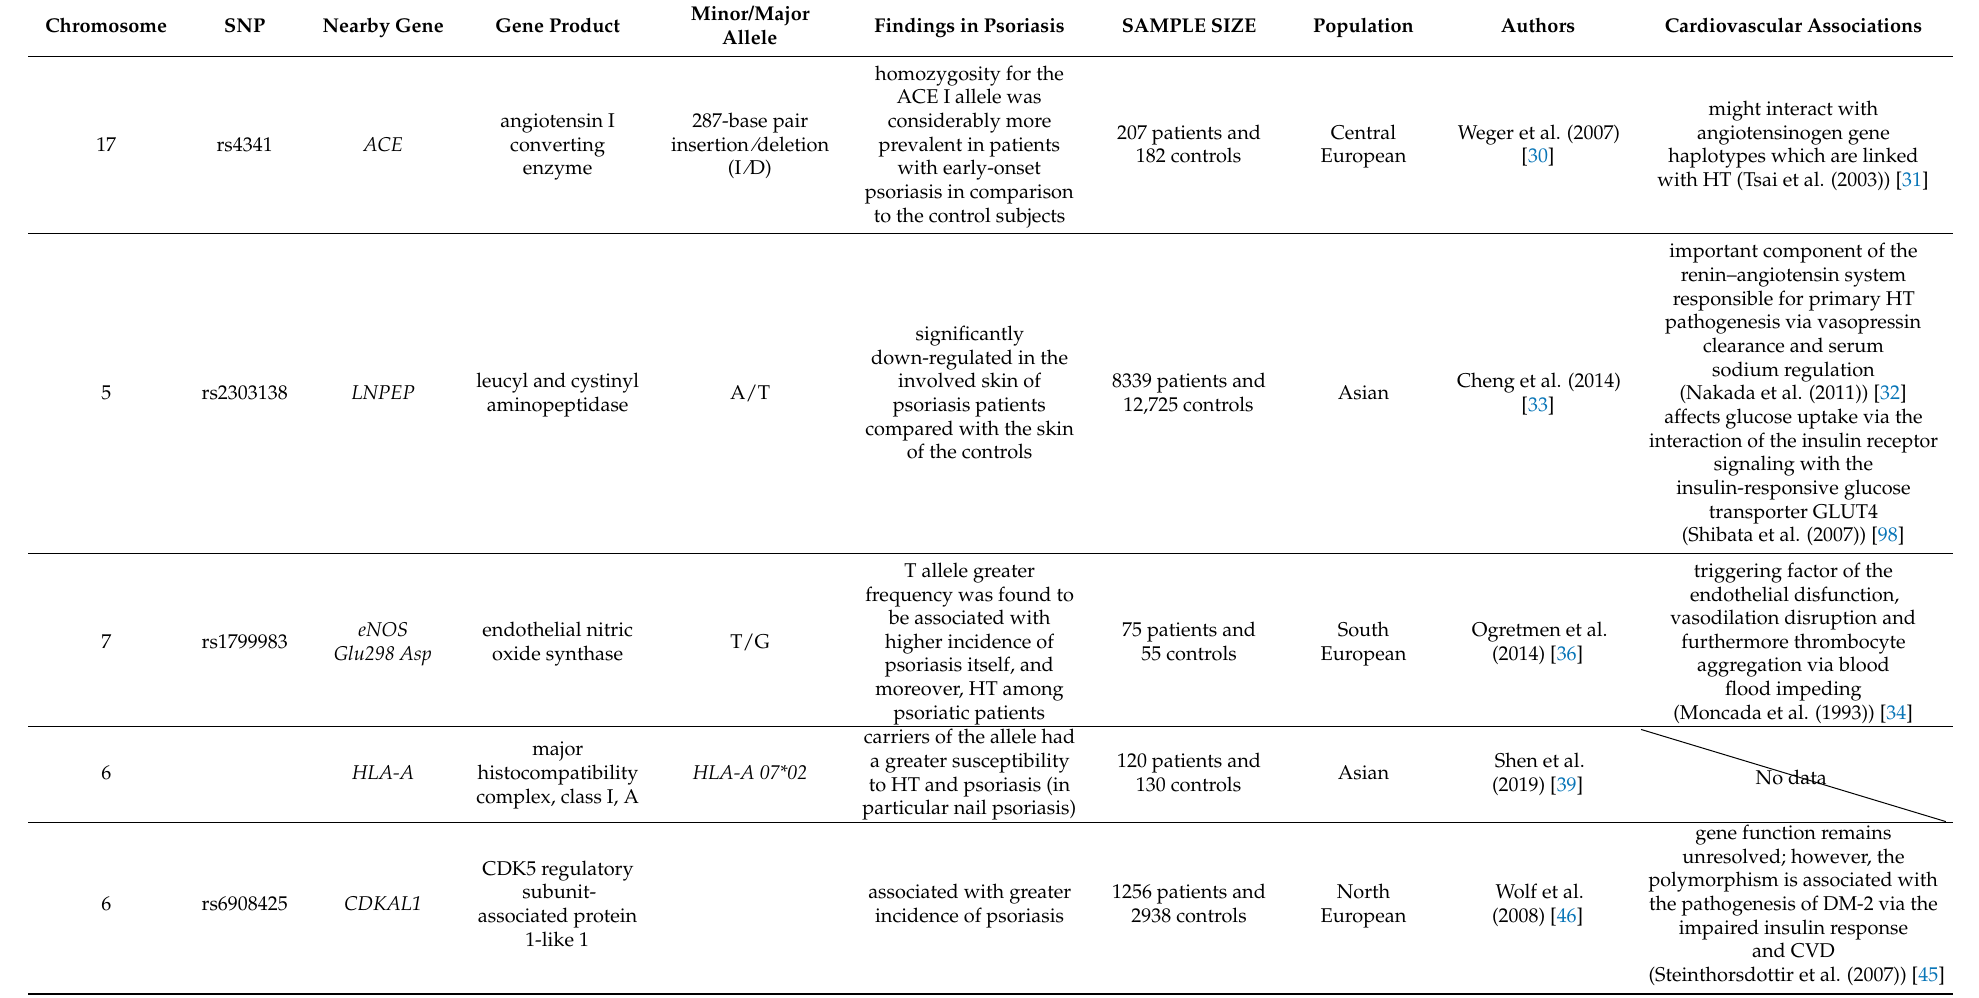
Table 2. Genetic linkage of psoriasis and cardiovascular risk